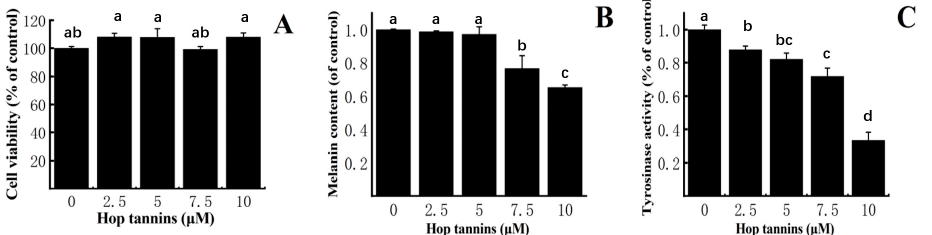
Figure 4. Effect of hop tannins on cell viability ( A ), melanin content ( B ), and tyrosinase activity ( C )